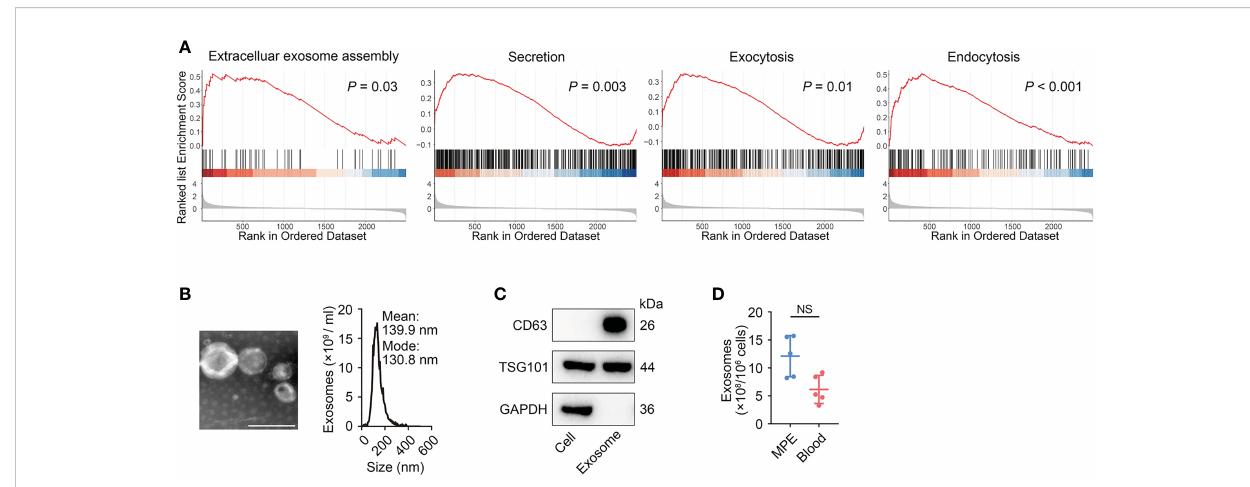
FIGURE 3 M j s could secrete exosomes. (A) GSEA analyses revealed that M j s in MPE exhibited higher pathway activity for “ extracellular exosomes assembly ” , “ secretion ” , “ exocytosis ” , and “ endocytosis ” as compared to blood. All P -values were calculated by permutation test according to the standard GSEA procedure. (B) A representative transmission electron microscopy image of puri fi ed exosomes (left panel) and the characterization of puri fi ed exosomes by using nanoparticle tracking (right panel). Scale bar, 100 nm. (C) Western blot analysis for CD63, TSG101, and GAPDH in the whole cell lysate and puri fi ed exosomes. (D) Total exosomes in M j s puri fi ed from MPE (n = 5) and blood (n = 5). Data are presented as mean ± SEM. Mann- Whitney test U; NS, not signi fi